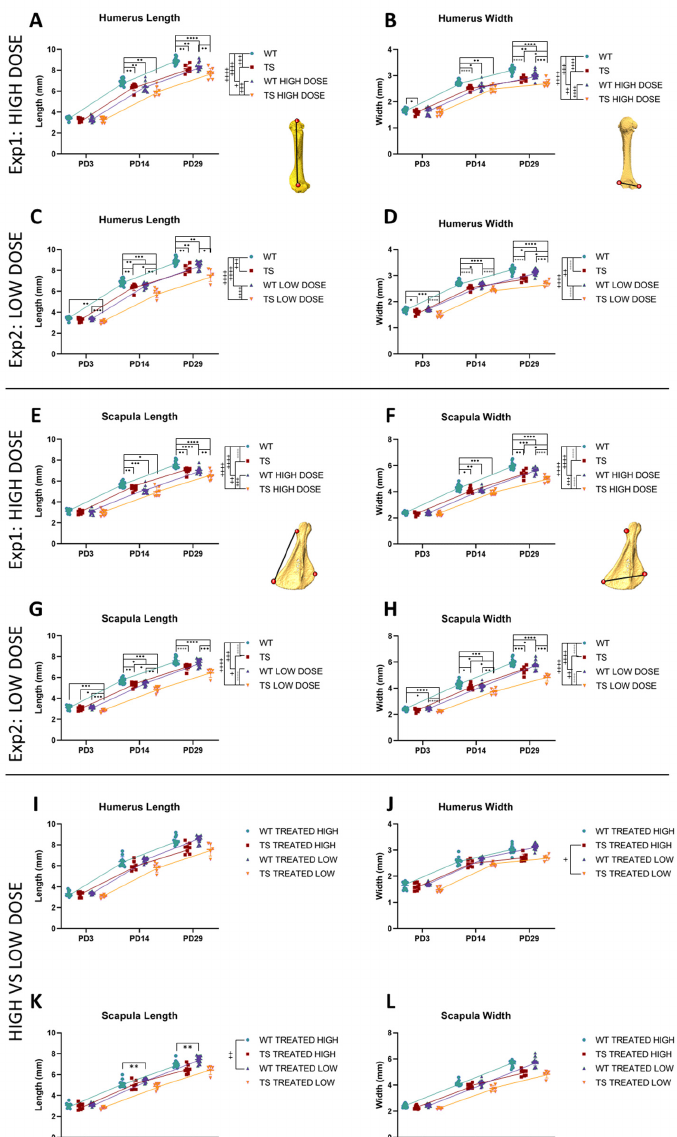
Figure 7. Postnatal length and width of the humerus and scapula for wildtype and trisomic mice and effects of high- and low-dose GTE-EGCG treatment across development. Euclidean distance between landmarks representing the ( A , C ) humerus length, ( B , D ) humerus width, ( E , G ) scapula length, and ( F , H ) scapula width at PD3, PD14, and PD29. ( I–L ) Comparison of the effects of the high-dose and the low-dose treatment. Data are presented as the mean +/ − standard deviation. ( + ) p < 0.05; ( ++ ) p < 0.01; ( +++ ) p < 0.001; ( ++++ ) p < 0.0001; Mixed-effects analysis across timepoints; (*) p < 0.05; (**) p < 0.01; (***) p < 0.001; (****) p < 0.0001; pairwise tests by timepoint. Sample size: Experimental setting 1: (PD3) WT = 15, TS = 8, WT treated = 13 (14 humerus length), TS treated = 9; (PD14) WT = 19, TS = 8, WT treated = 11, TS treated = 7; (PD29) WT = 17 (18 humerus length and width), TS = 6, WT treated = 12, TS treated = 8. Experimental setting 2: (PD3) WT = 15, TS = 8, WT treated = 15, TS treated = 6; (PD14) WT = 19, TS = 8, WT treated = 15, TS treated = 6; (PD29) WT = 17 (18 humerus length and width), TS = 6, WT treated = 15, TS treated = 5. The mice analyzed may differ across stages but represent overall ontogenetic